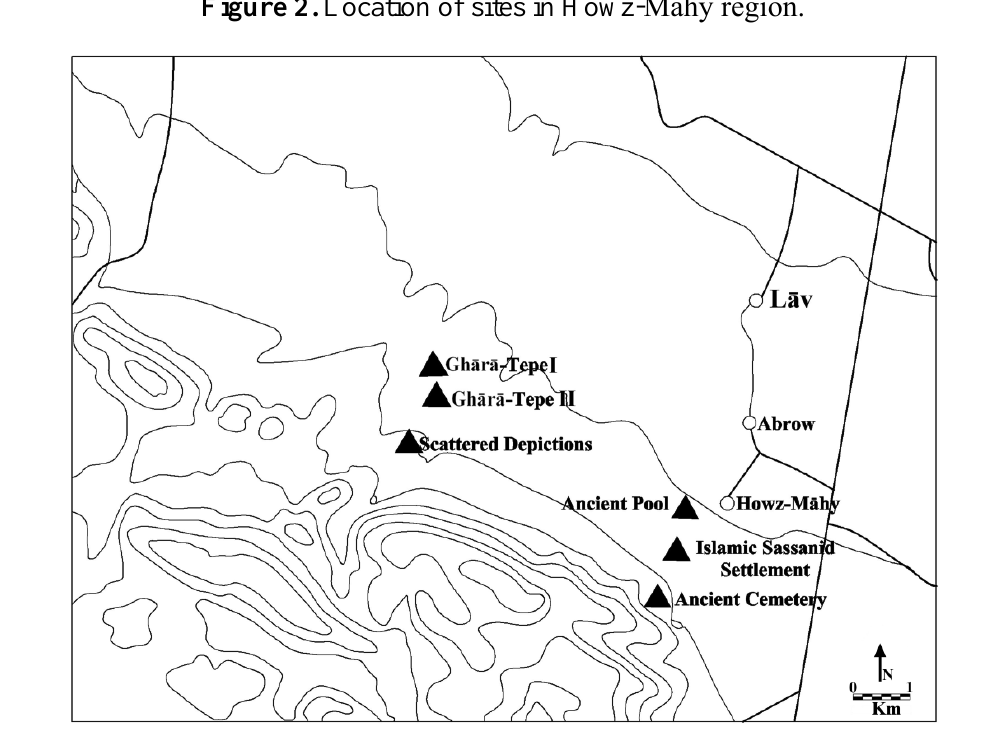
Figure 2. Location of sites in Howz-Māhy